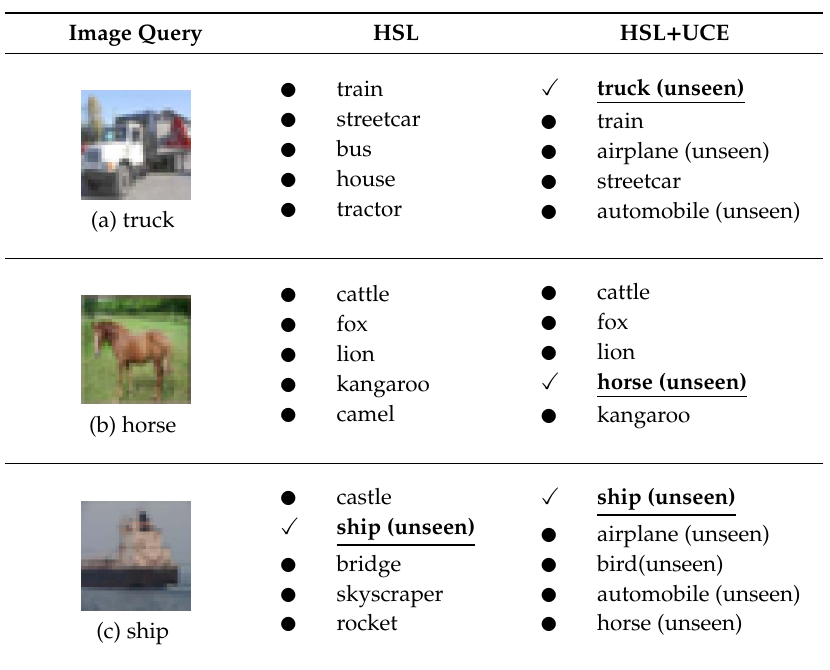
Table 3. Retrieved semantic labels for unseen class image